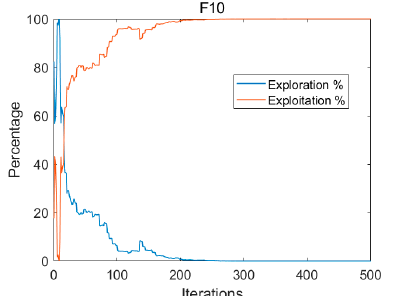
Figure 7. Exploration and exploitation phases for the MGTO algorithm using CEC2020.